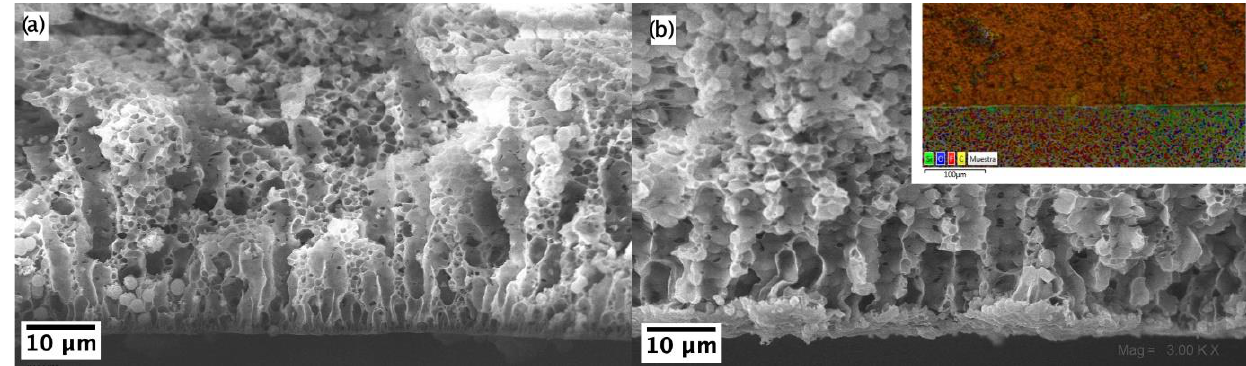
Figure 3. Cross-section SEM micrograph of ( a ) unmodified and ( b ) modified membrane surface. Inset of ( b ) shows the surface EDS mapping.